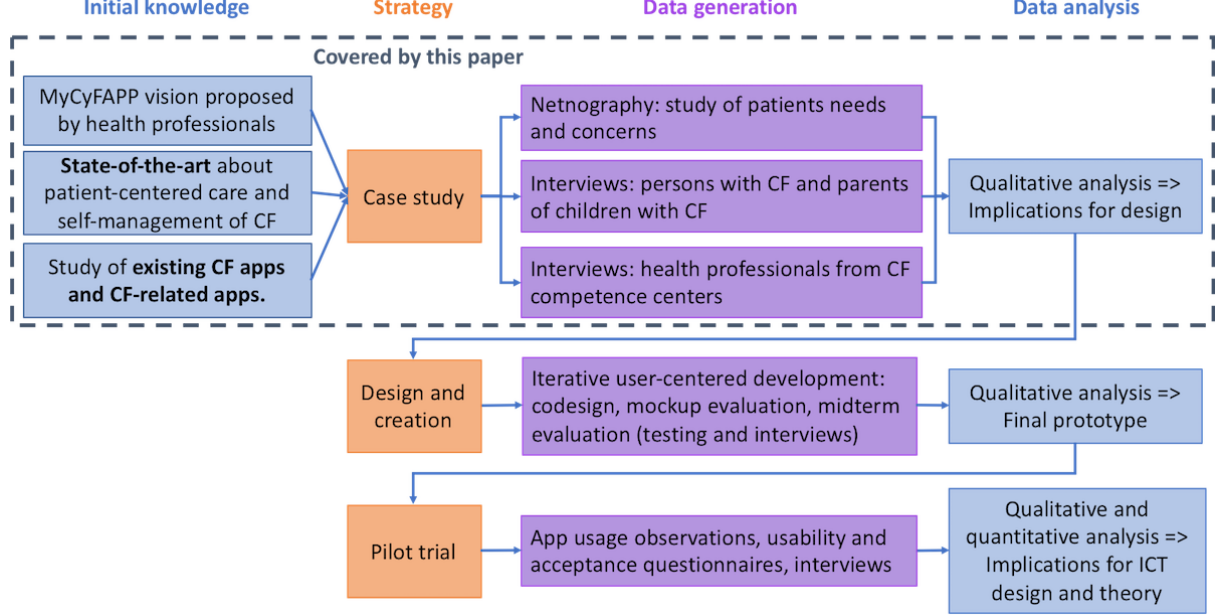
Figure 1. Strategies for the information and communication technology (ICT) research in MyCyFAPP. CF: cystic